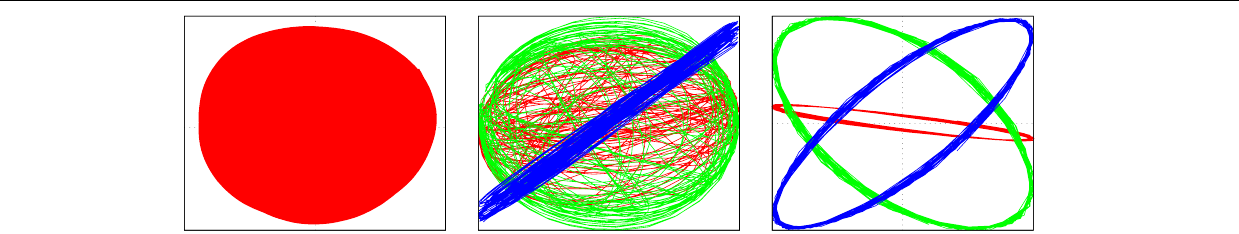
FIGURE 3 | Motion of the Spherical in a basin . Trajectory as seen from above (left panel), parametric plot of the controls y i ( t ) with i ∈ {1,2,3} vs. the sensor x 2 ( t ) in the early “orientation” phase (middle) and later on when the robot is in an orbit of constant height in the basin (right).